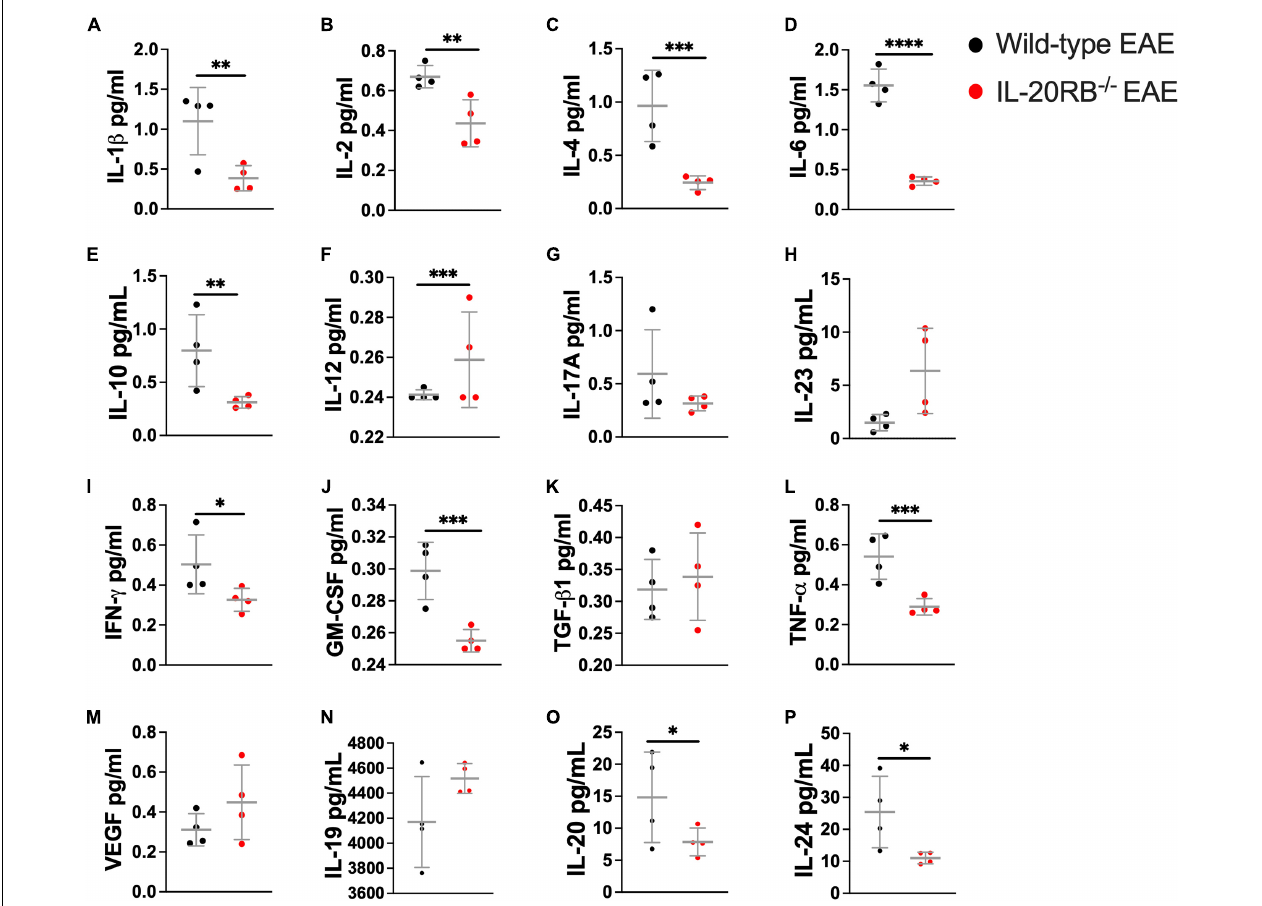
FIGURE 3 | Cytokine expression in the spinal cord of wild-type mice and IL-20RB − / − mice at peak of EAE. Cytokines and VEGF expression within spinal cord tissues was detected by multianalyte bead-based immunoassay (A–M) and ELISA (N–P) , n = 4, for wild-type mice at peak of EAE (peak, ∼ 14 dpi) (black circle) and sham-immunized, IL-20RB − / − mice (red circle), and sham-immunized (sham-immunized not shown). One-way ANOVA analysis followed by Sidak’s post hoc test was perform comparing primarily wild-type mice and IL-20RB − / − mice at peak of EAE and showed that mean differences to be significant for many cytokines: IL-1 β (mean ± SEM: 1.10 ± 0.21 vs. 0.39 ± 0.08, p < 0.01, A ), IL-2 (mean ± SEM: 0.67 ± 0.05 vs. 0.44 ± 0.06, p < 0.01, B ), IL-4 (mean ± SEM: 0.96 ± 0.17 vs. 0.24 ± 0.03, p < 0.001, C ), IL-6 (mean ± SEM: 1.36 ± 0.10 vs. 0.36 ± 0.03, p < 0.0001, D ), IL-10 (mean ± SEM: 0.80 ± 0.17 vs. 0.31 ± 0.03, p < 0.01, E ), IL-12 (mean ± SEM: 0.24 ± 0.001 vs. 0.26 ± 0.01, p < 0.001, F ), IFN- γ (mean ± SEM: 0.50 ± 0.07 vs. 0.33 ± 0.03, p < 0.05, I ), GM-CSF (mean ± SEM: 0.30 ± 0.01 vs. 0.26 ± 0.003, p < 0.001, J ), TNF- α (mean ± SEM: 0.54 ± 0.06 vs. 0.29 ± 0.02, p < 0.001, L ), IL-20 (mean ± SEM: 14.83 ± 3.54 vs. 7.85 ± 1.09, p <